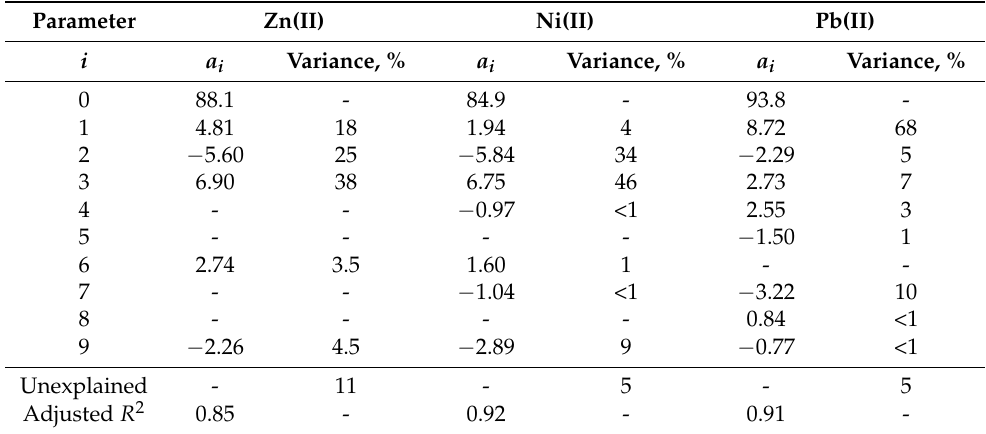
Table 5. Best fit parameters for the removal of Zn(II), Ni(II), and Pb(II) based on CCD3. Parameter